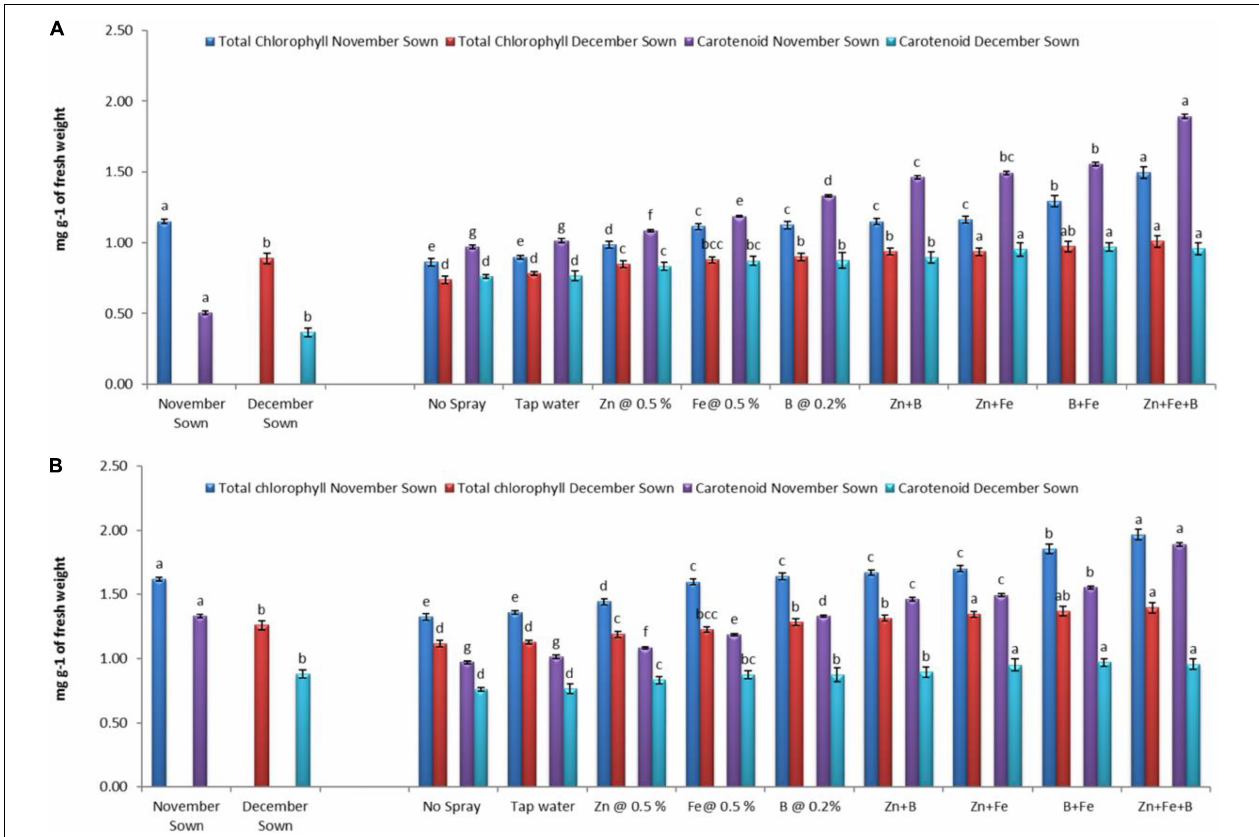
FIGURE 2 | Total chlorophyll content and carotenoid for different sowing dates and foliar spray treatments in the (A) 2018–19 and (B) 2019–20 lentil cropping seasons. Values are means, and bars represent ± SEM ( n = 3). Different letters indicate significant differences between means.